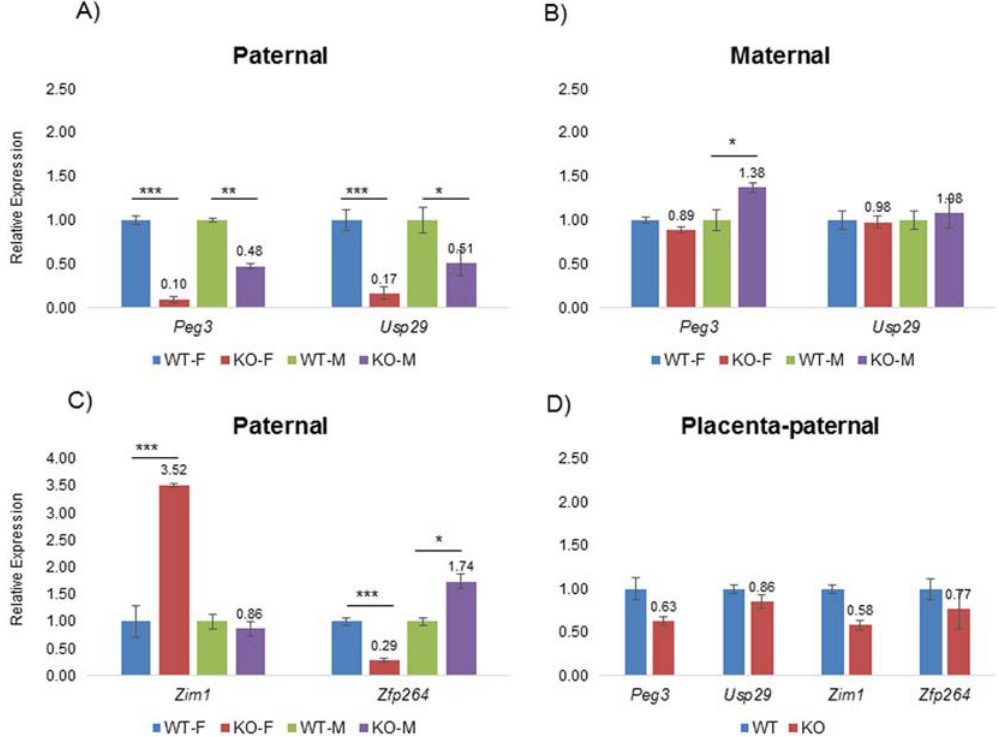
Figure 4. Mutational effects on transcriptional levels. A series of qRT-PCR were performed to test potential effects of the mutation on the transcriptional levels of the imprinted genes within the Peg3 domain. This series of analyses used the total RNA isolated from the brain of the one-day-old pups carrying the mutant allele paternally ( A , C ) and maternally ( B ). The expression levels of each gene were first normalized with an internal control ( β -actin), and the normalized values were further compared between the wild-types and the heterozygotes. The relative levels are presented in a graph with standard errors (S.E.). A similar series of expression analyses were also conducted using a set of 14.5-dpc placenta ( D ). Statistical significance by Student’s t-test was indicated in the following manner: * < 0.05, ** < 0.01, *** < 0.001. The series of analyses were repeated with two independent sets of biological